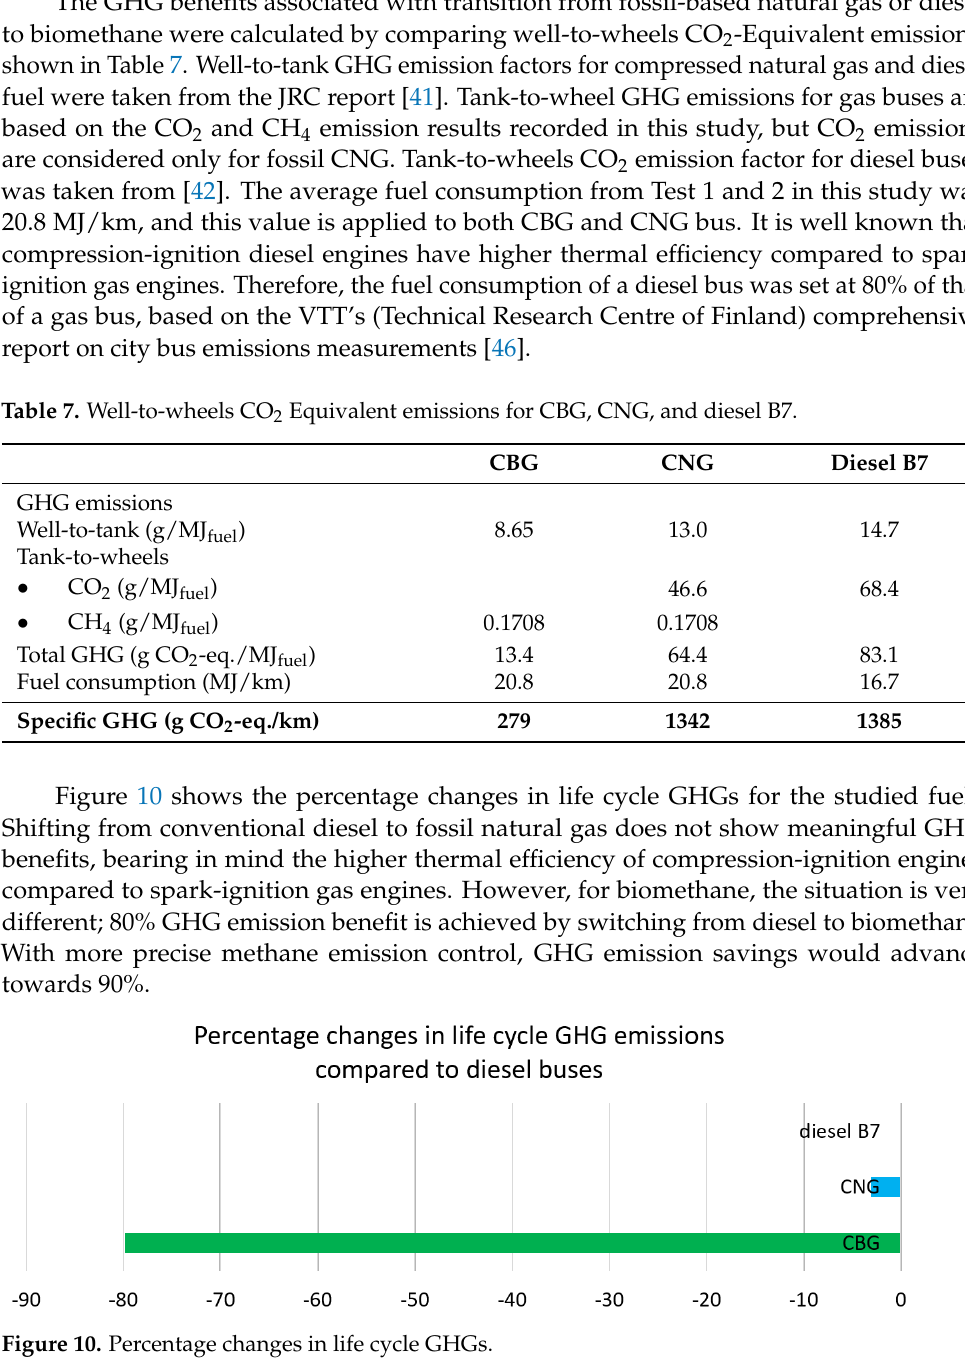
Figure 10. Percentage changes in life cycle GHGs.